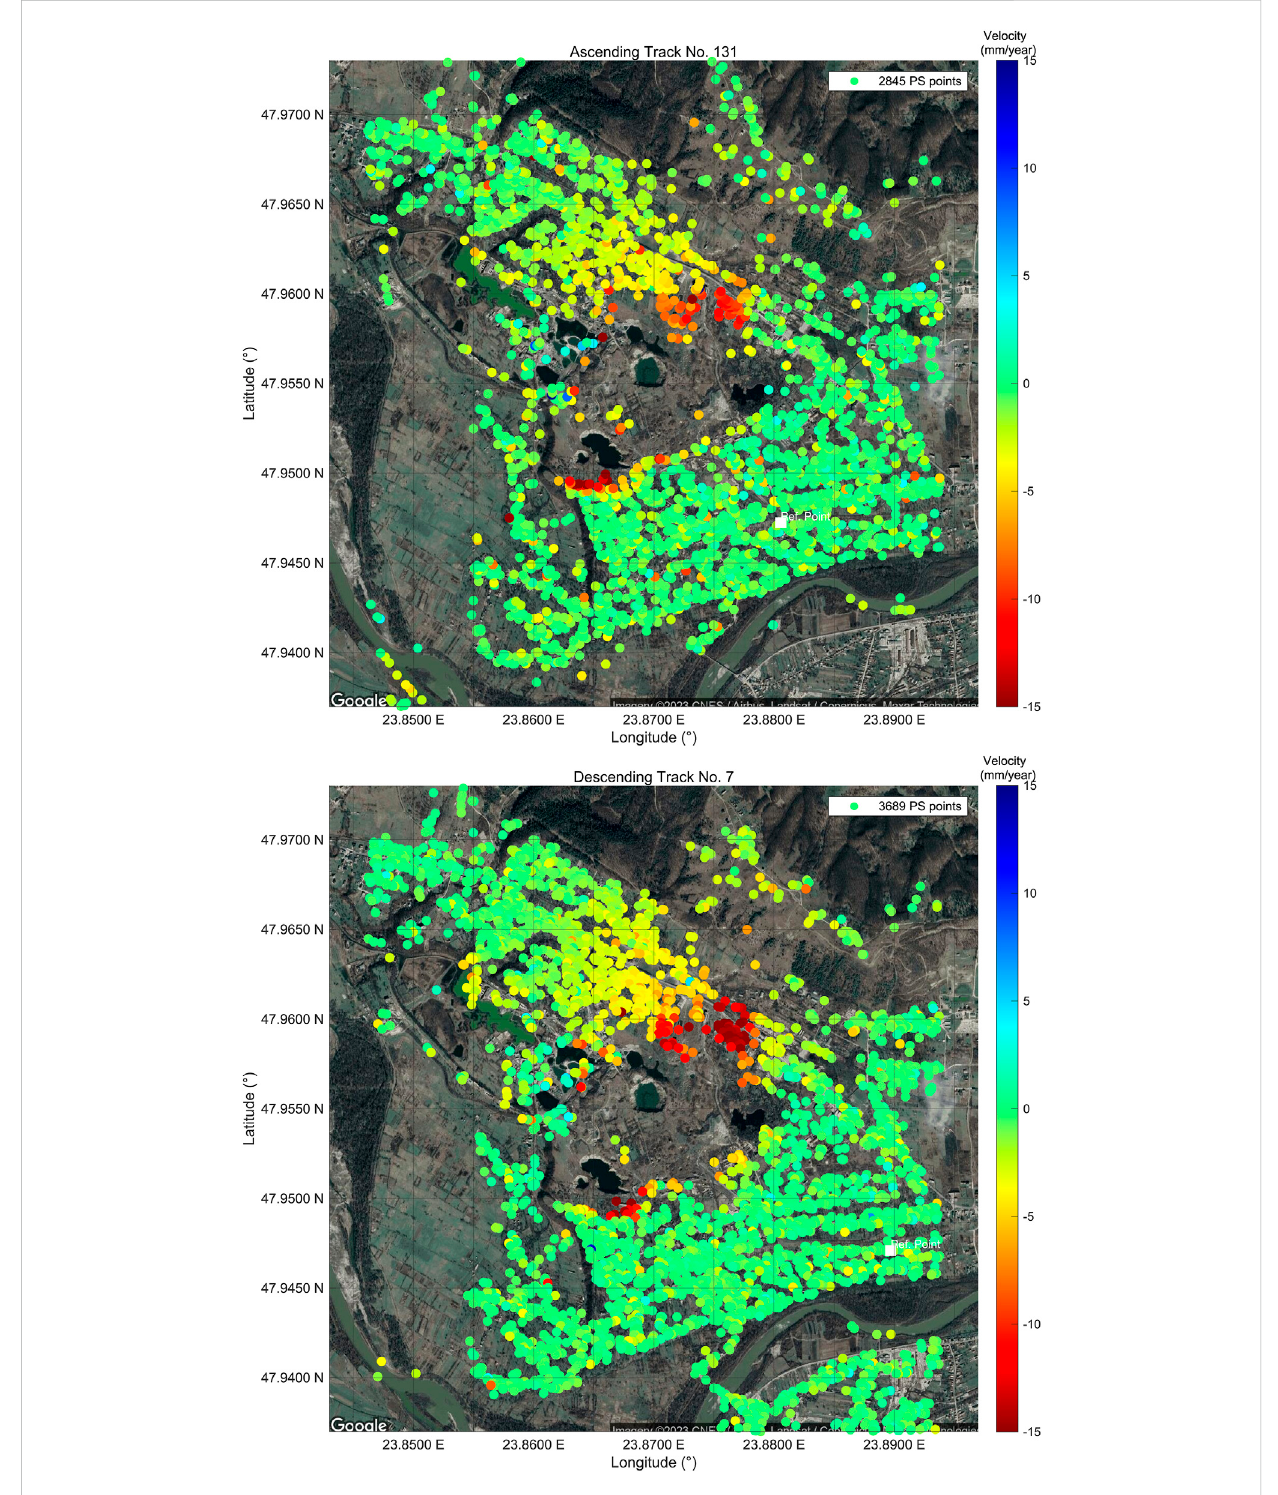
FIGURE 5 Line-of-sight (LOS) displacement velocity map from Ascending Track No. 131 (top) and Descending Track No. 7 (bottom).